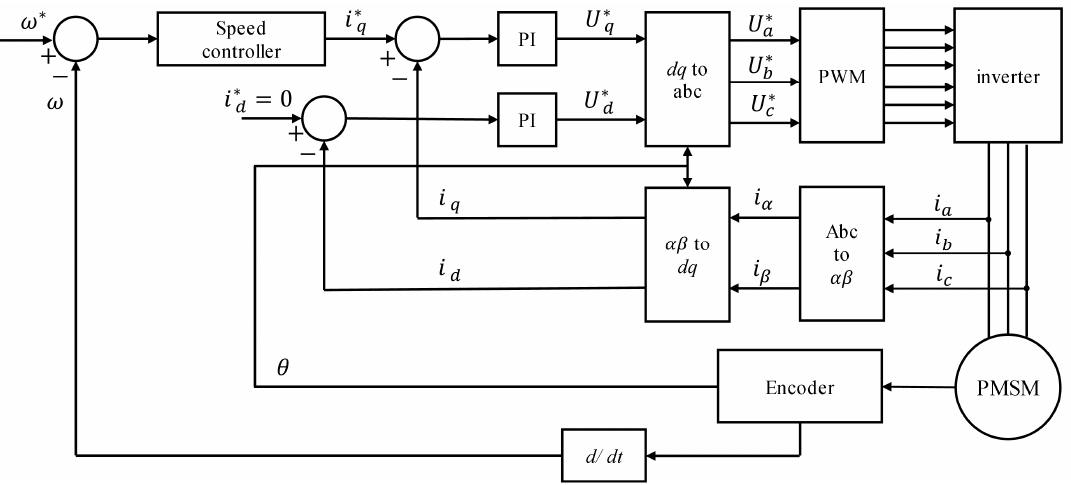
Figure 1. Block diagram of the PMSM vector control system.